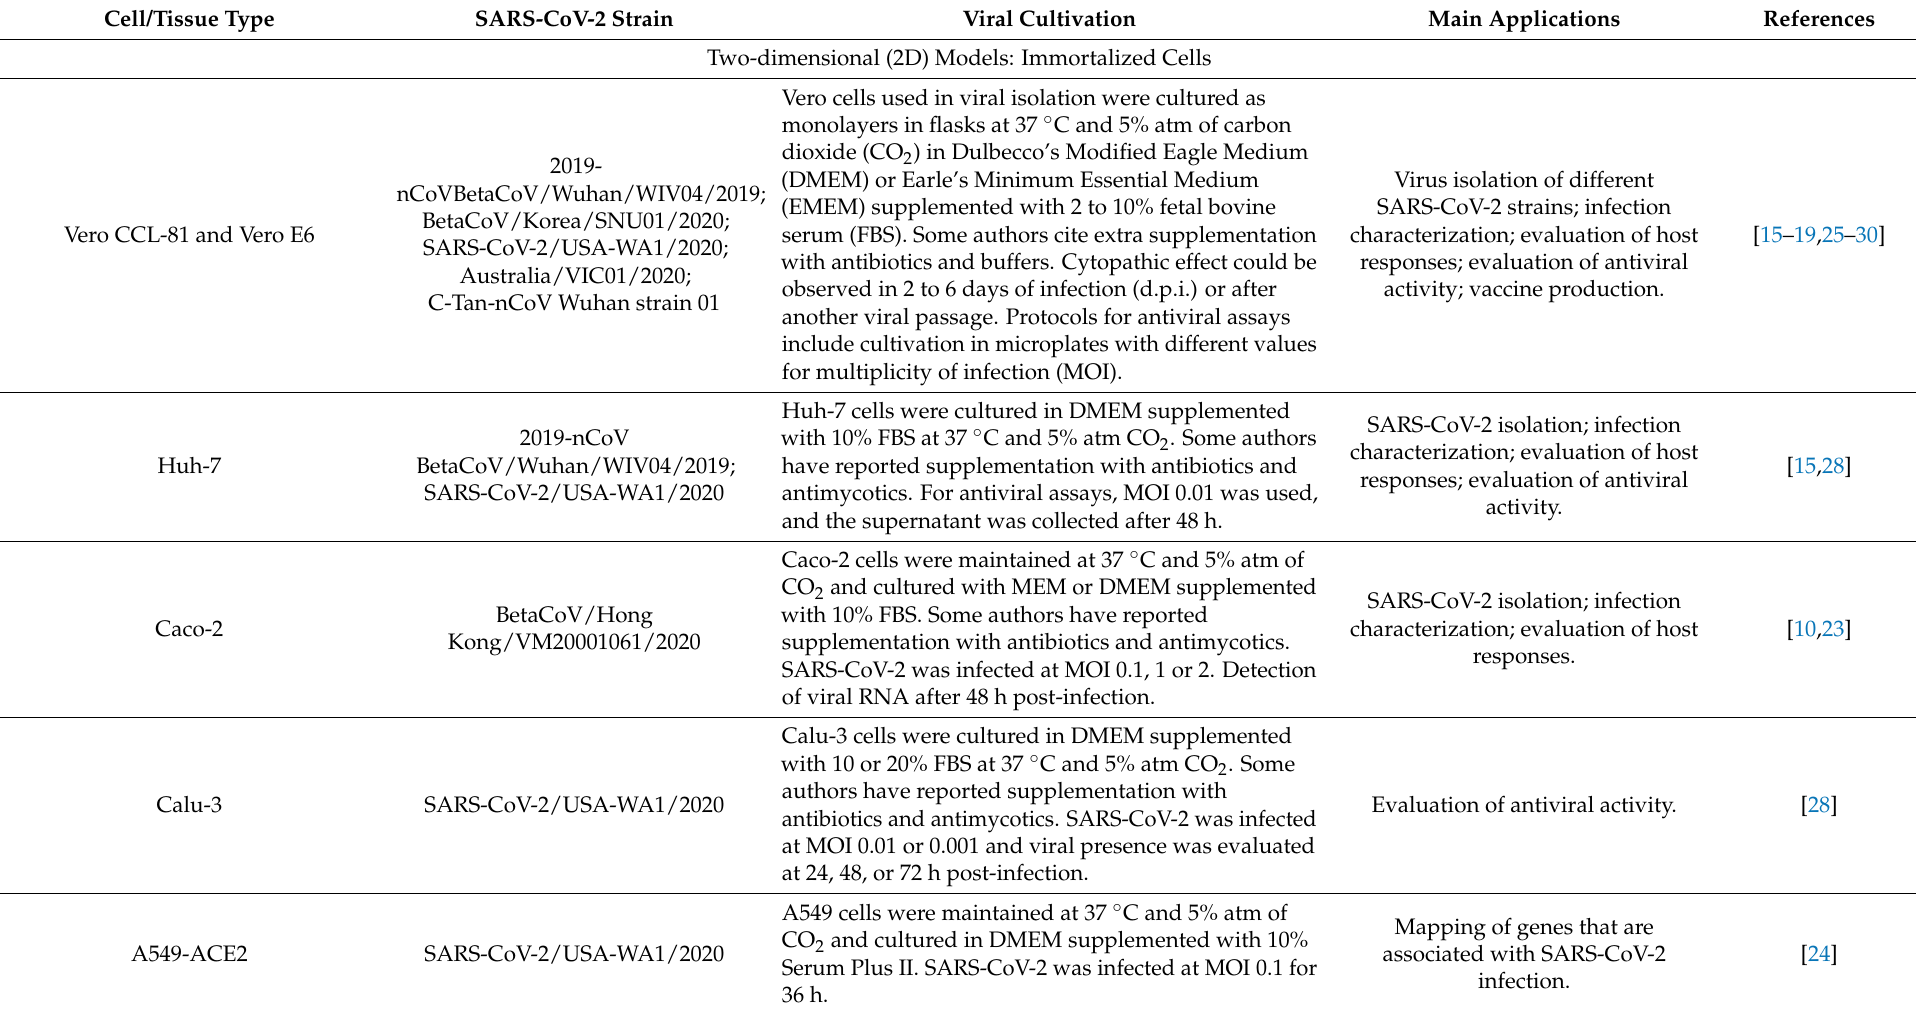
Table 1. In Vitro and ex vivo models for severe acute respiratory syndrome coronavirus 2 (SARS-CoV-2) studies. Cell/Tissue